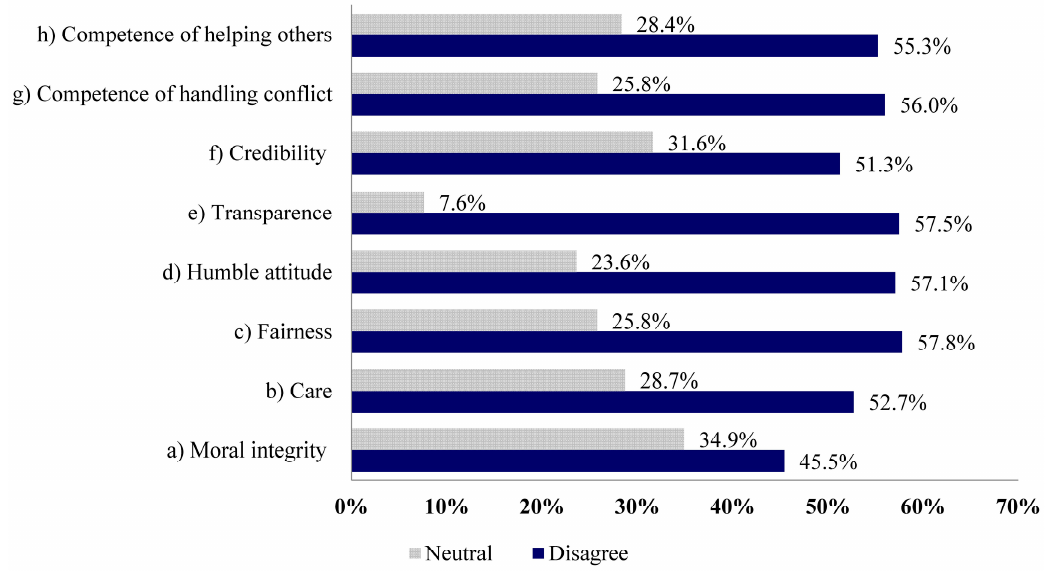
Figure 3. Farmers’ perceptions of trust attributes.